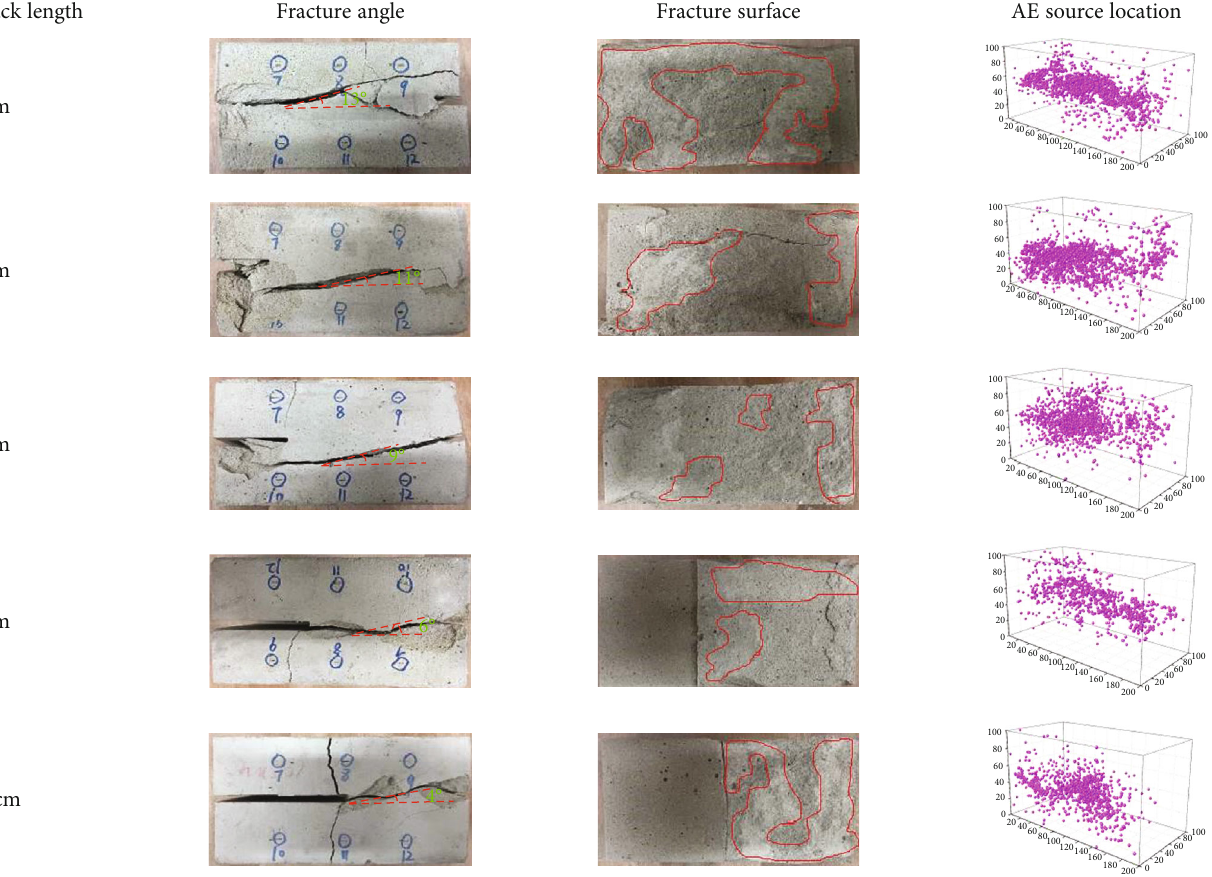
Table 3: Failure mode of specimens with di ff erent unilateral